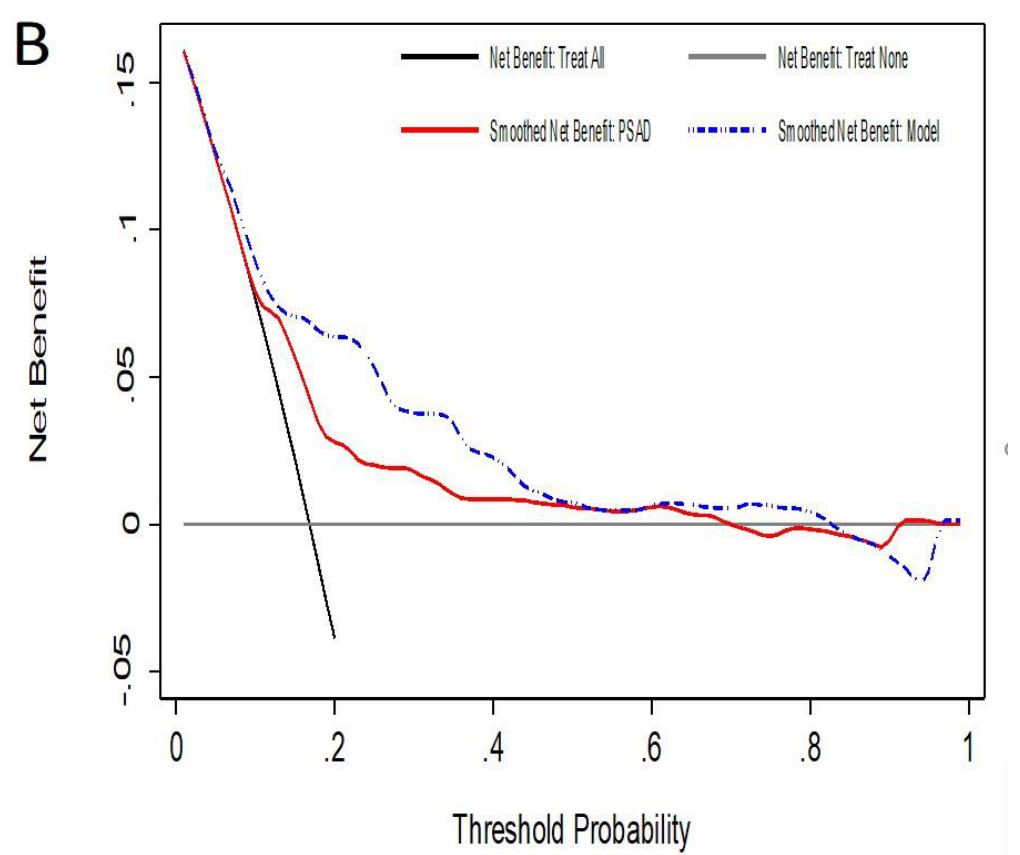
Figure 3. The ROC curves and AUCs show the efficacy of mPSAD (PSAD in the graphic) and MRI- PMbdex (model in the graphic) in detecting csPCa in men with PI-RADS 3 ( A ). The DCAs showing the net benefit of mPSAD and MRI-PMbdex over performing biopsies on all men according to the csPCa probability threshold ( B ). The selected thresholds of MRI-PMbdex and mPSAD provided sensitivities of 78.9% and 92.7% as well as specificities of 52.1% and 20.5%, respectively, in men with PI-RADS 3. MRI-PMbdex avoided 46.8% of prostate biopsies, while mPSAD avoided 18.3%. How- ever, the probabilities of missed csPCa were 21.7% and 7.3%, respectively. mPSAD did not detect 2.8% of PCa with ISUP-GG ≥ 3 (3/109), whereas MRI-PMbdex did not detect 10% (11/109) (Table 5). Table 5. Performance of mPSAD and MRI-PMbdex, with respective thresholds of 0.628 ng/mL 2 and 13.5%, in men with PI-RADS 3.